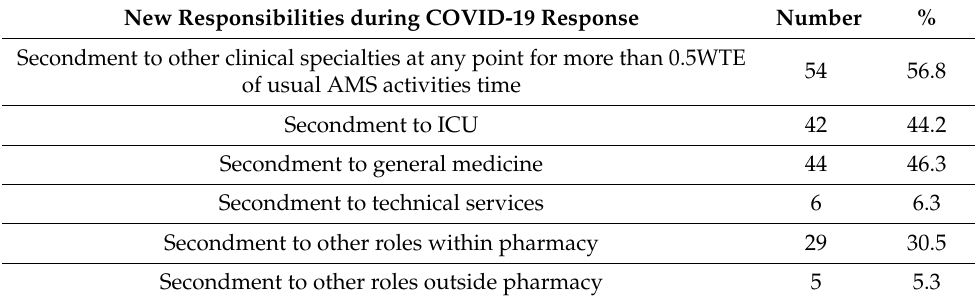
Table 5. New responsibilities for infection management pharmacy